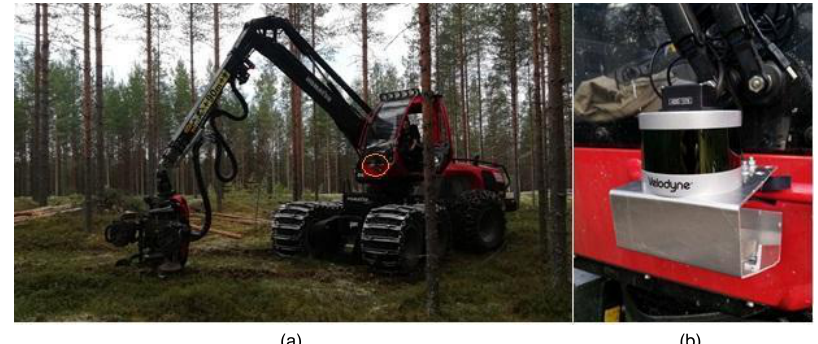
Figure 2. ( a ) Komatsu Forest 931.1 forest harvester. The lidar scanner is marked by a red circle in the front of the windshield of the cabin. ( b ) A close-up of the lidar